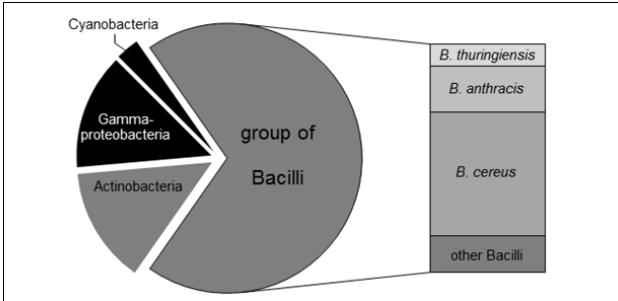
FIGURE 2 | Distribution of A D P-like enzymes in bacteria. Using the eggNOG3.0 database, 72 putative host organisms for D SPs were identified. 12 out of 72 organisms are gram-negative (colored in black). The remaining 60 gram-positive species (shown in gray) mainly relates to Bacilli strains (50 proteases). High populations of putative D SPs were predicted for pathogenic microorganisms like B. cereus (27 D SPs) and B. anthracis (10 D SPs). The less pathogenic organism B. thuringiensis is supposed to serve as host for five D